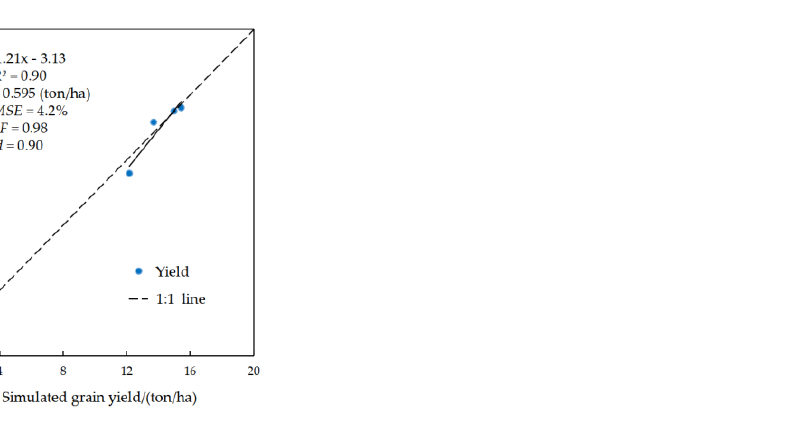
Figure 5. Calibration and verification results for the measured and simulated yields in all years (Zhaozhou (2014), Harbin (2014–2015), and Zhaozhou (2017).